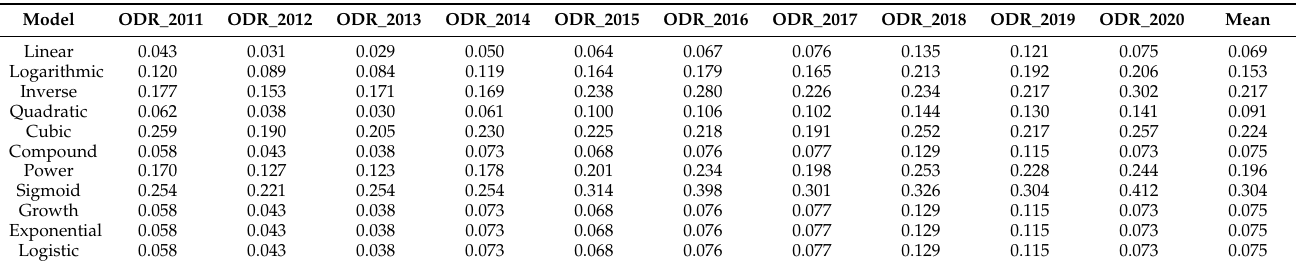
Table 3. Correlation coefficients ( R 2 ) of different prediction models using the provincial ODR in